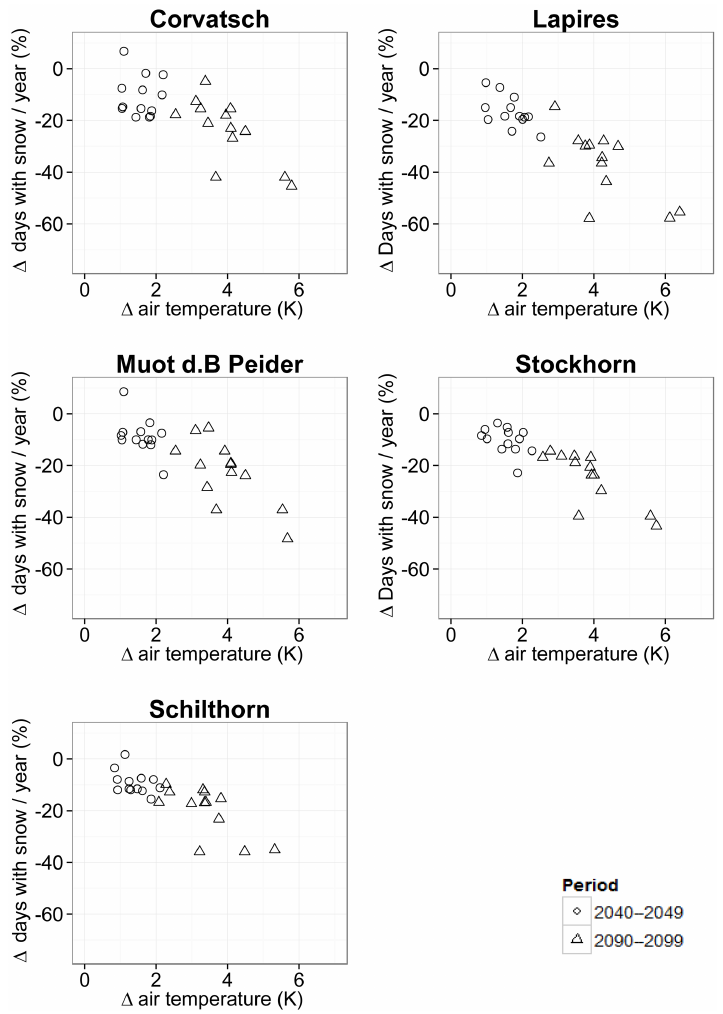
Figure 8. Relationship between the decreasing snow duration and the increase of air temperature for the decades 2040–2049 (dots, repre- senting the 10-year means (cid:49) for each GCM/RCM chain) and 2090–2099 (triangles, representing the 10-year means (cid:49) for each GCM/RCM chain), in comparison with the decade 2000–2010. The trend is variable between the sites (from − 5.29 to − 8.76%K − 1 ), but all sites show a linear correlation between (cid:49) air temperature and reduction of days with